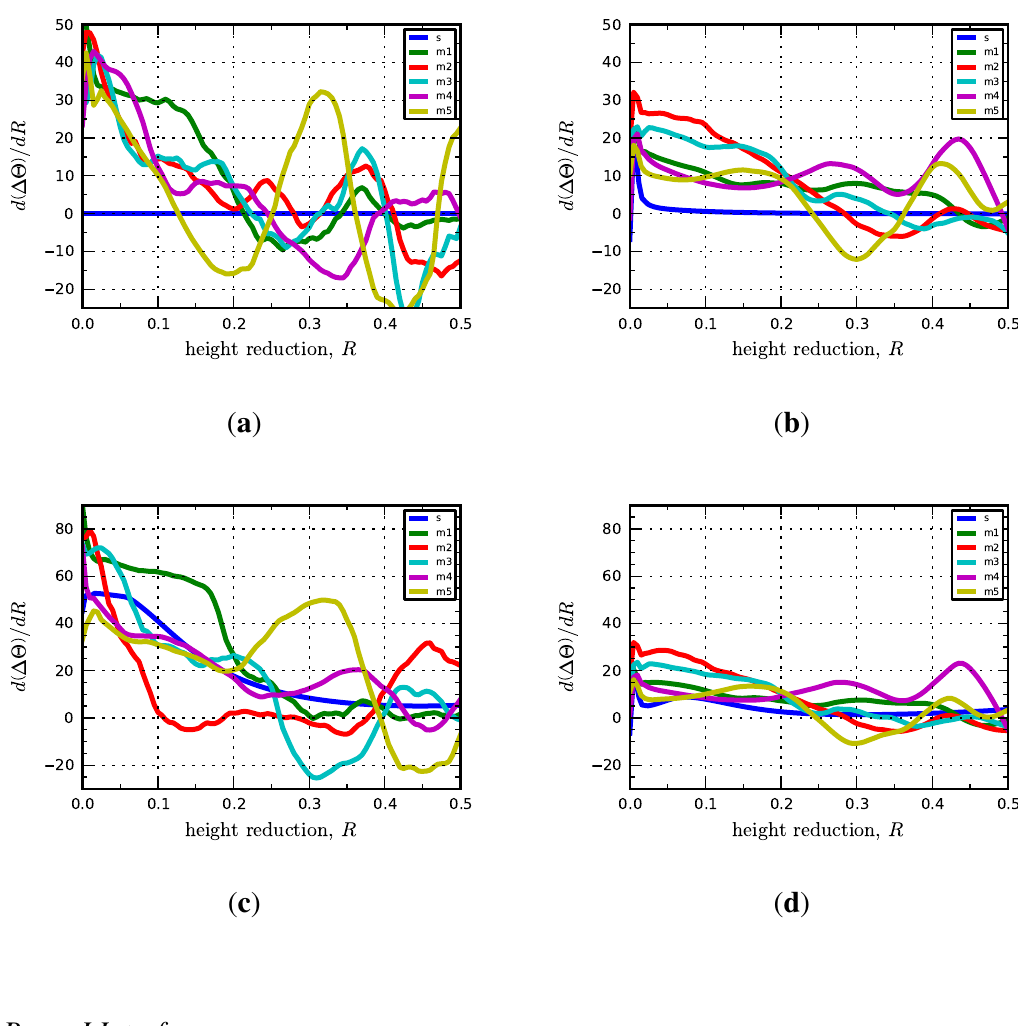
Lattice reorientation rate plotted as a function of height reduction for the ( a ) copper phase in the Goss-I interface; ( b ) niobium phase in the Goss-I interface; ( c ) copper phase in the Z-I interface; and ( d ) niobium phase in the Z-I interface. In the legend, “s” refers to the periodic bicrystal simulations and the “m1, m2, ...” refer to the different realizations of the multicrystal